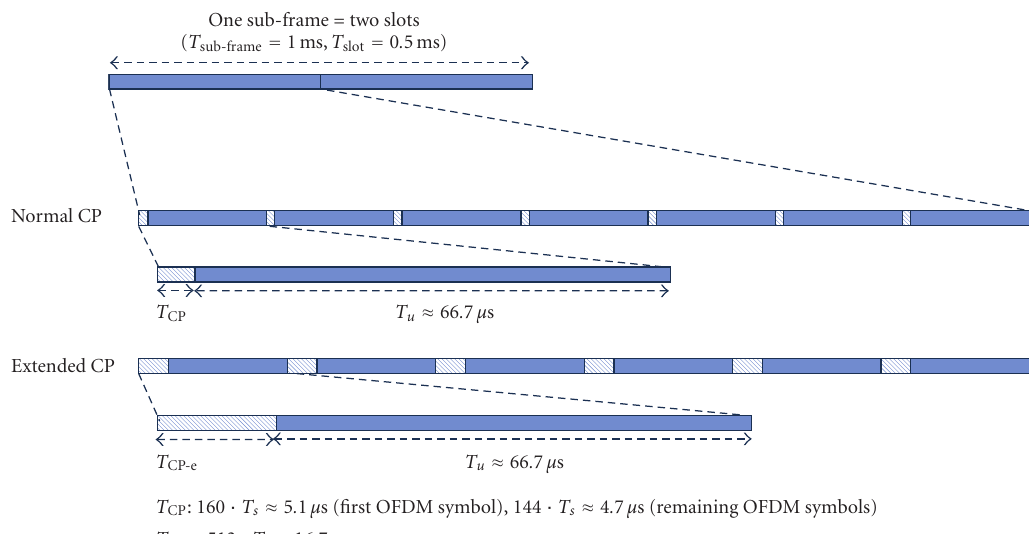
Figure 20: LTE downlink subframe and slot structure. One subframe consisting of two equal-size slots. Each slot consisting of 7/6 OFDM symbols (normal/extended cyclic prefix).